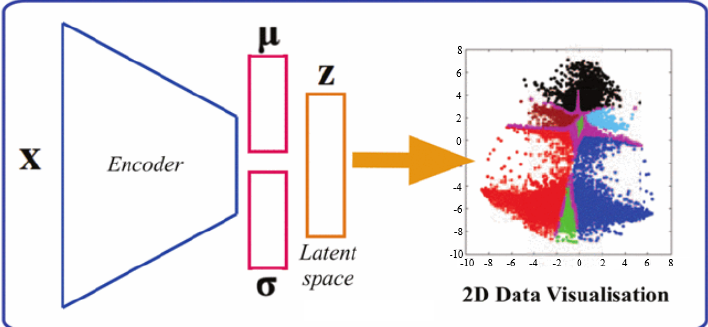
Figure 22. Data visualization